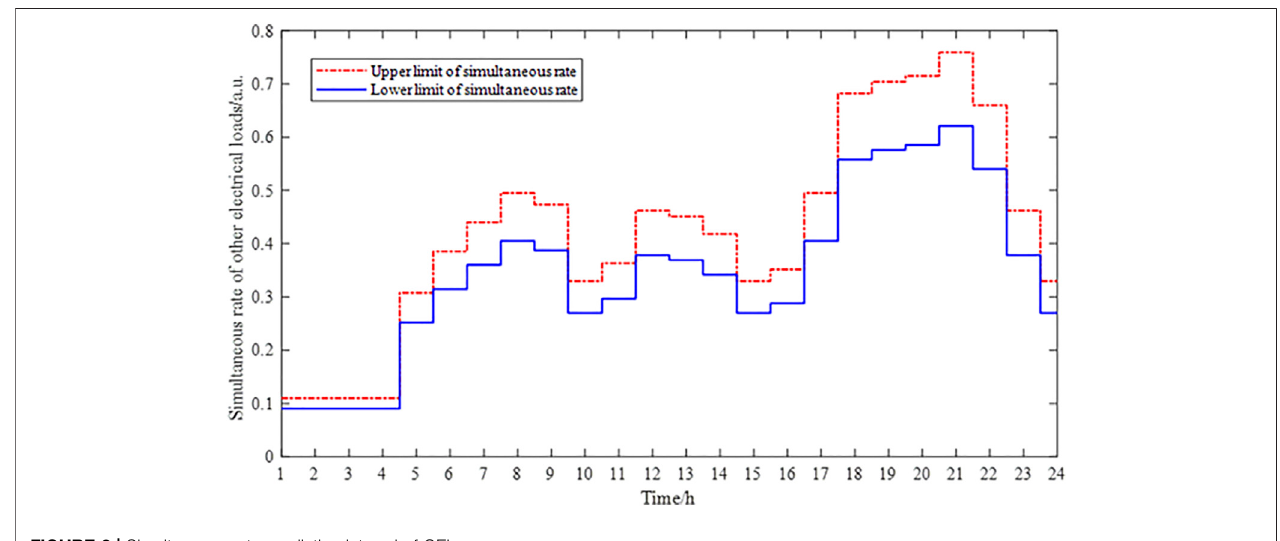
FIGURE 8 | Simultaneous rate prediction interval of OELs.